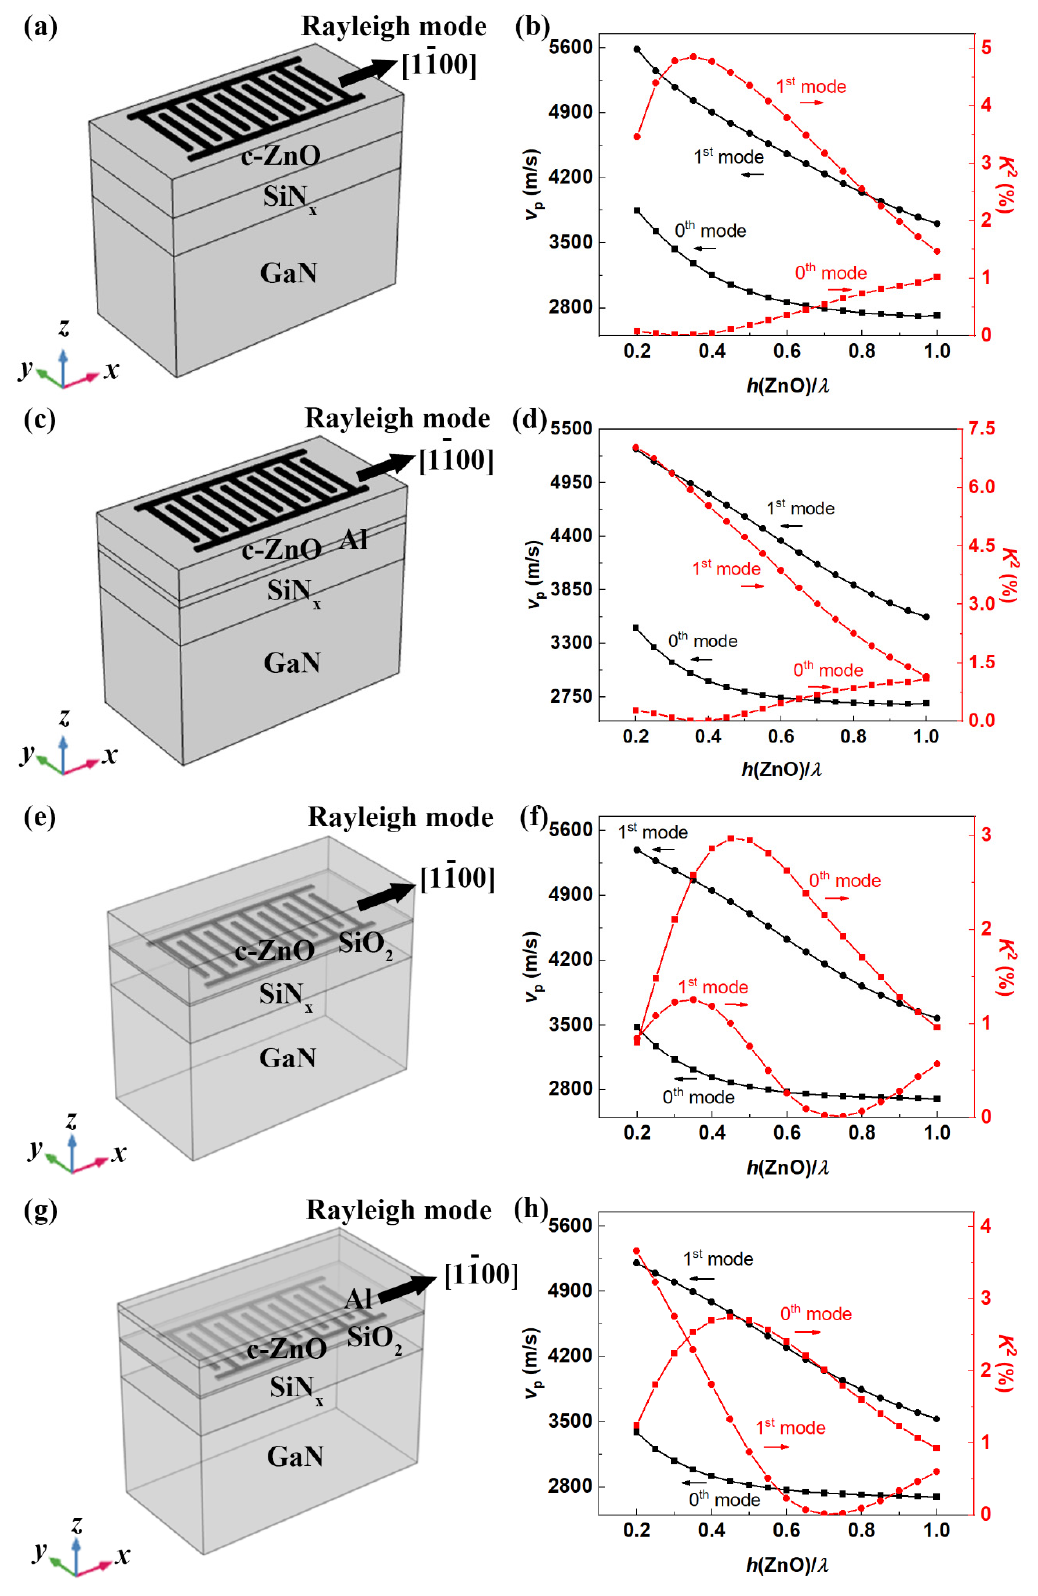
Figure 10. Four structures ( a , c , e , g ) where 0th Rayleigh-mode wave and 1st Rayleigh-mode wave (Sezawa-mode wave) are excited, and their corresponding v p and K 2 dispersion patterns ( b , d , f , h ).